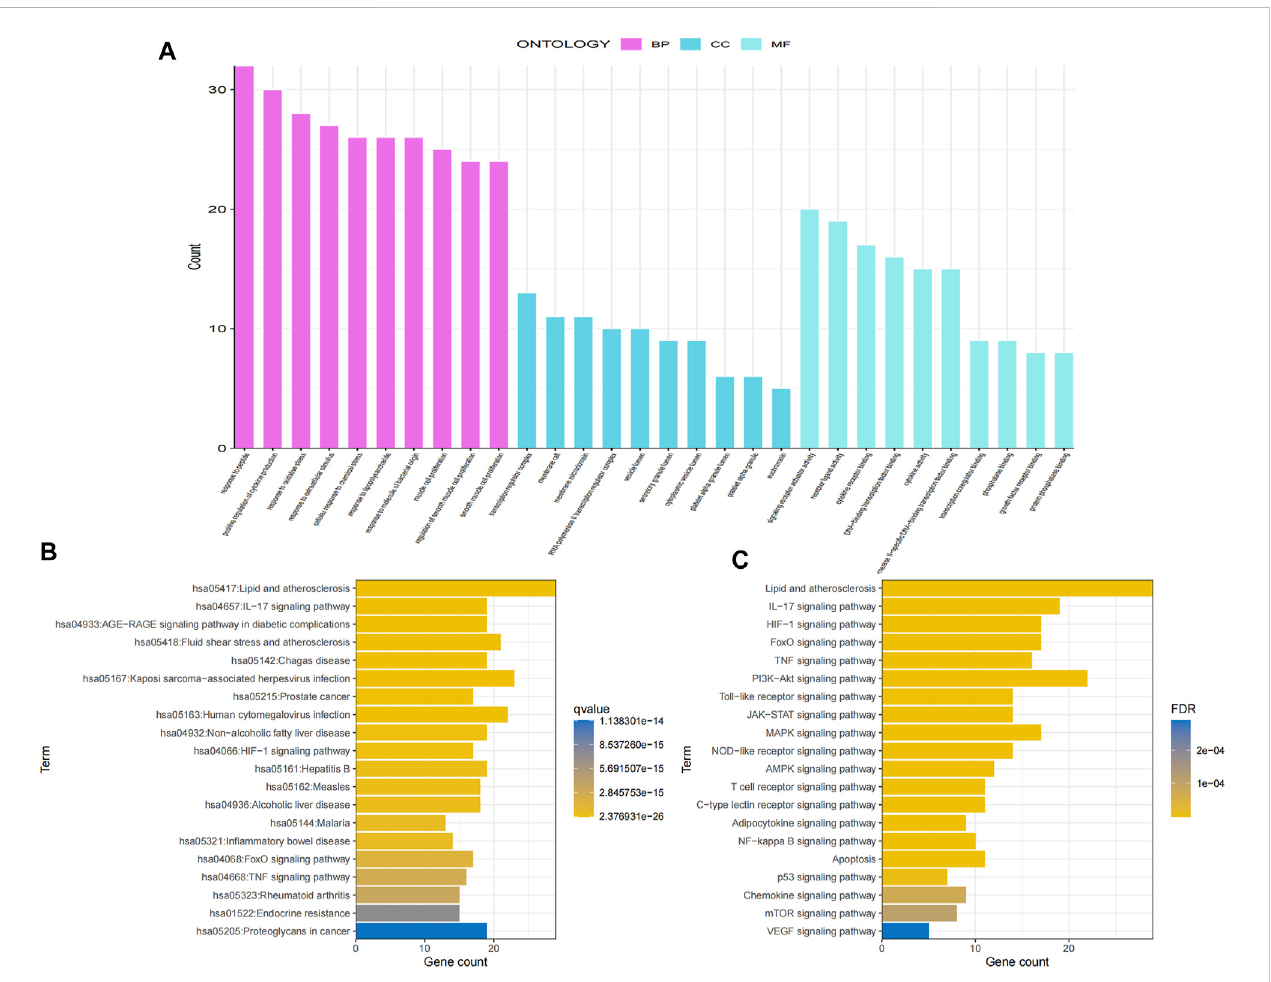
FIGURE 3 GeneOntology(GO) andKyotoEncyclopediaofGenesandGenomes(KEGG)enrichmentanalysesofpotential coretargets. (A) GOenrichmentanalysis. (B) KEGG enrichment analysis. (C) Screening of the top 20 ranked KEGG pathway